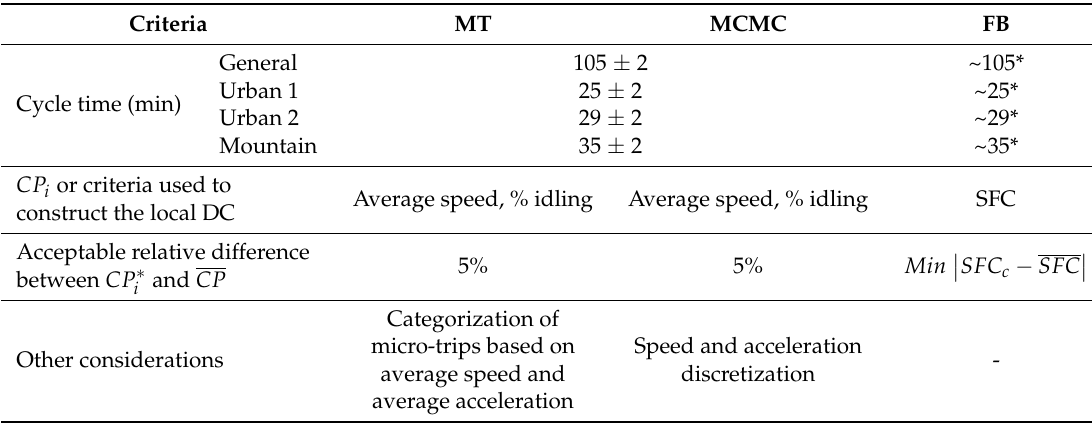
Table 3. Input parameters used in the three methods of constructing